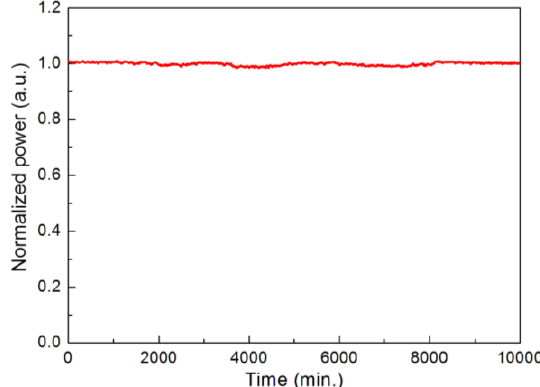
Figure 9. Measured normalized transmission of the silicate fiber at 976 nm as a function of pump exposure